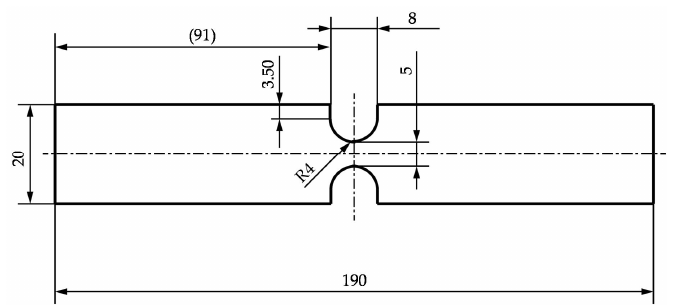
Figure A1. Geometry of the notched specimen. Table A6. Grinding steps.